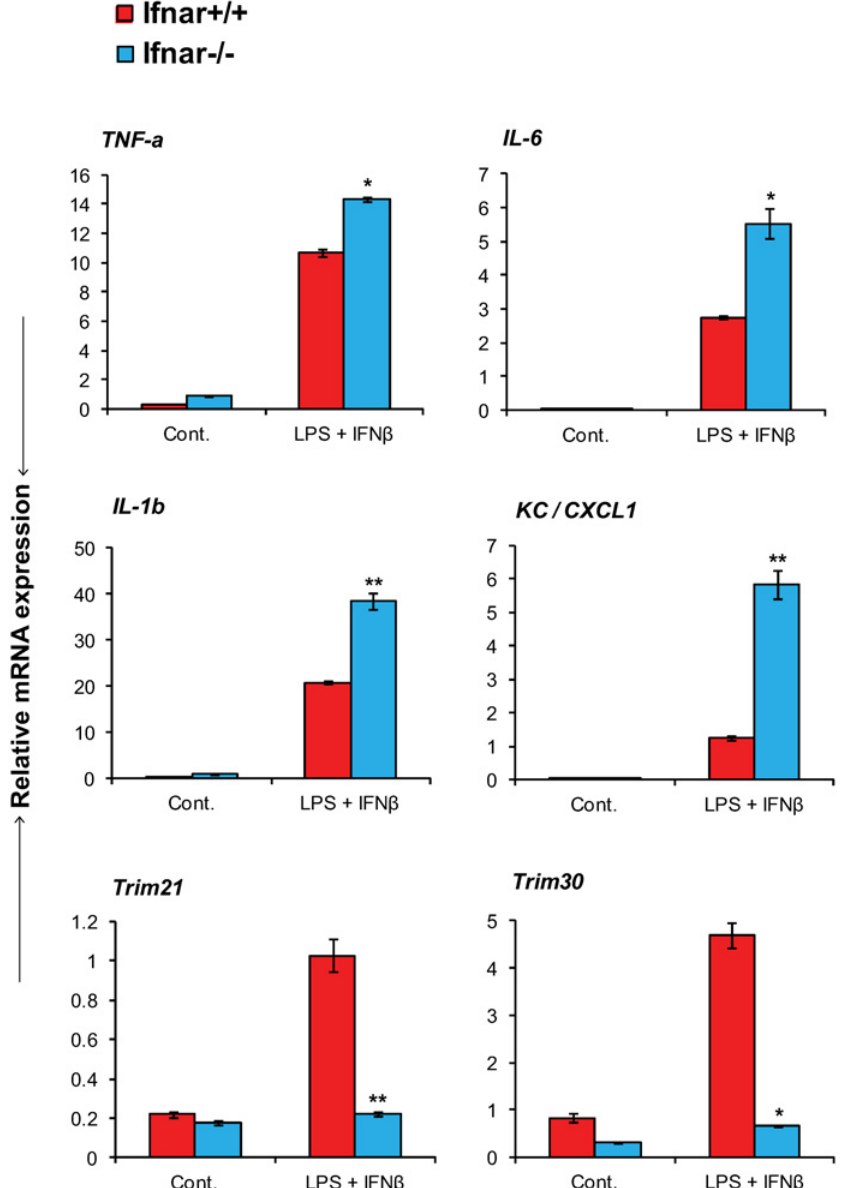
represent the average of duplicate samples from three individual experiments ± SEM. Asterisks denote * p (cid:1) 0.05, ** p (cid:1)